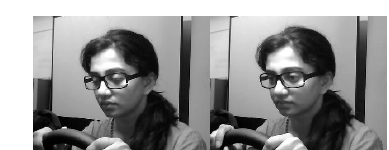
Figure 10. A video clip labeled as talking.